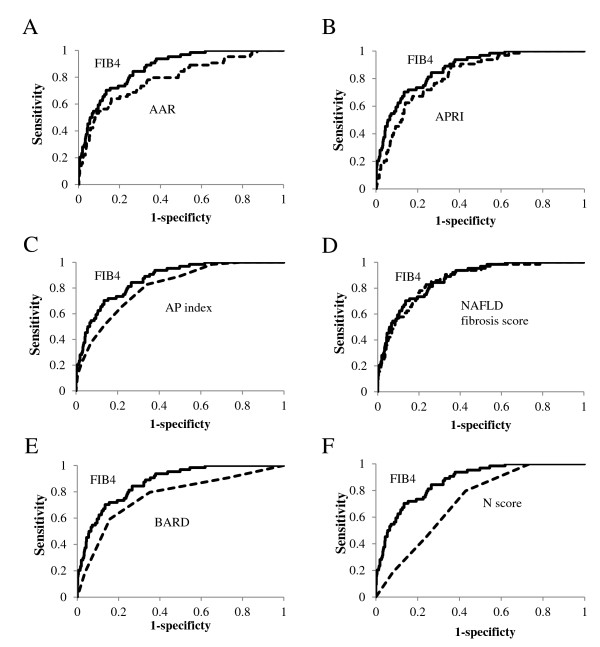
Comparison of ROCs of FIB4 and other panels for the diagnosis of advanced fibrosis.